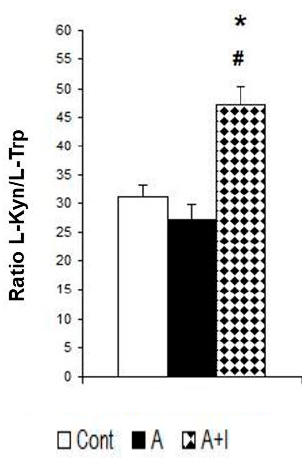
Figure 4. Patients with long-term titanium implants and amalgams have a higher L-kynurenine (Kyn)-L-trp ratio. Cont : control ( n = 30). Amalgam (A, n = 55). Dental titanium implants + Amalgam (A + I, n = 57). * p < 0.05 vs. Control group (Cont), # p < 0.05 vs. Amalgam group (A). Table 1. Systemic cytokine levels and L-kyn/L-trp ratios.